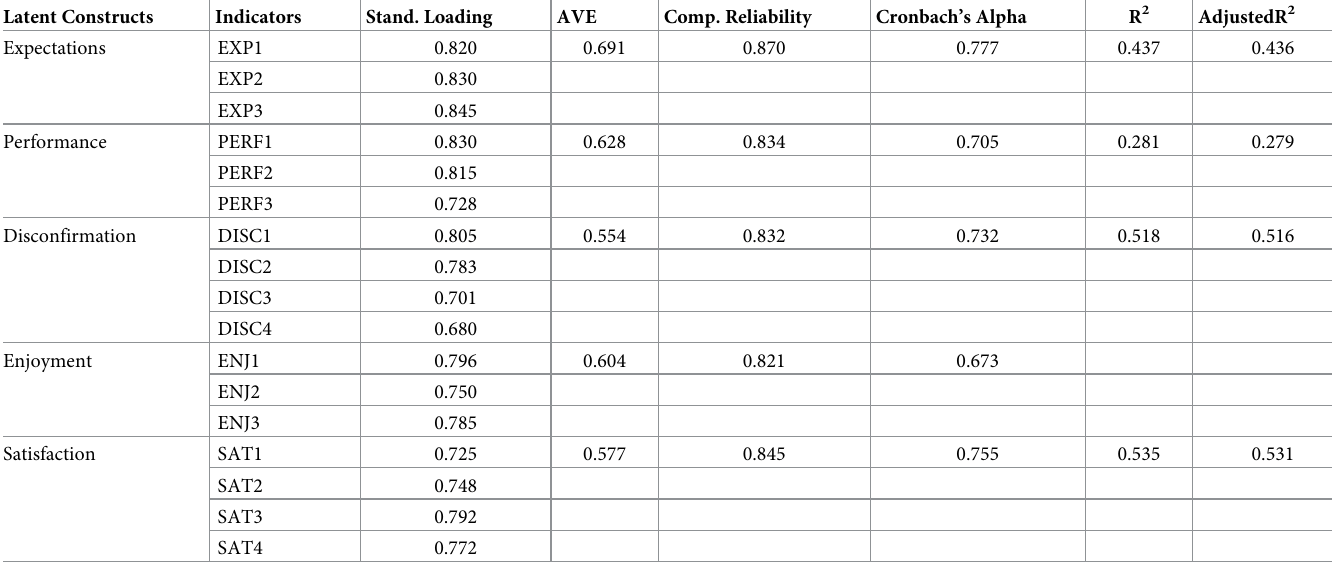
Table 2. Measurement model assessment.